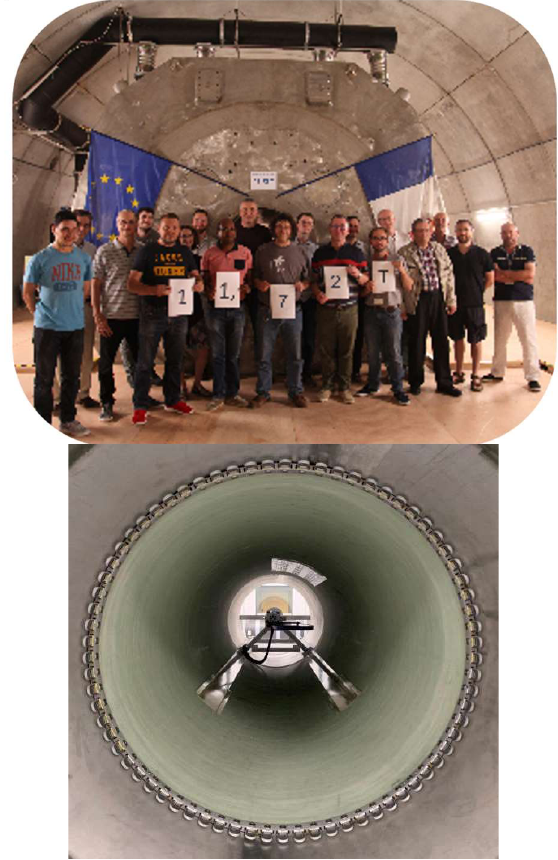
Fig. 2. Top: With the new record of 11.7 Tesla, ISEULT exceeds the most powerful MRI magnet currently in service in the world, based in Minneapolis, reaching 10.5 Tesla, but with a smaller central opening of 880 mm, compared to 900 mm for ISEULT. Bottom: The magnetic field must be homogeneous at 0.5 PPM (parts per million) around the patient's brain. 5904 pieces of shim (small iron pellets) were thus screwed onto their rails and installed inside the magnet